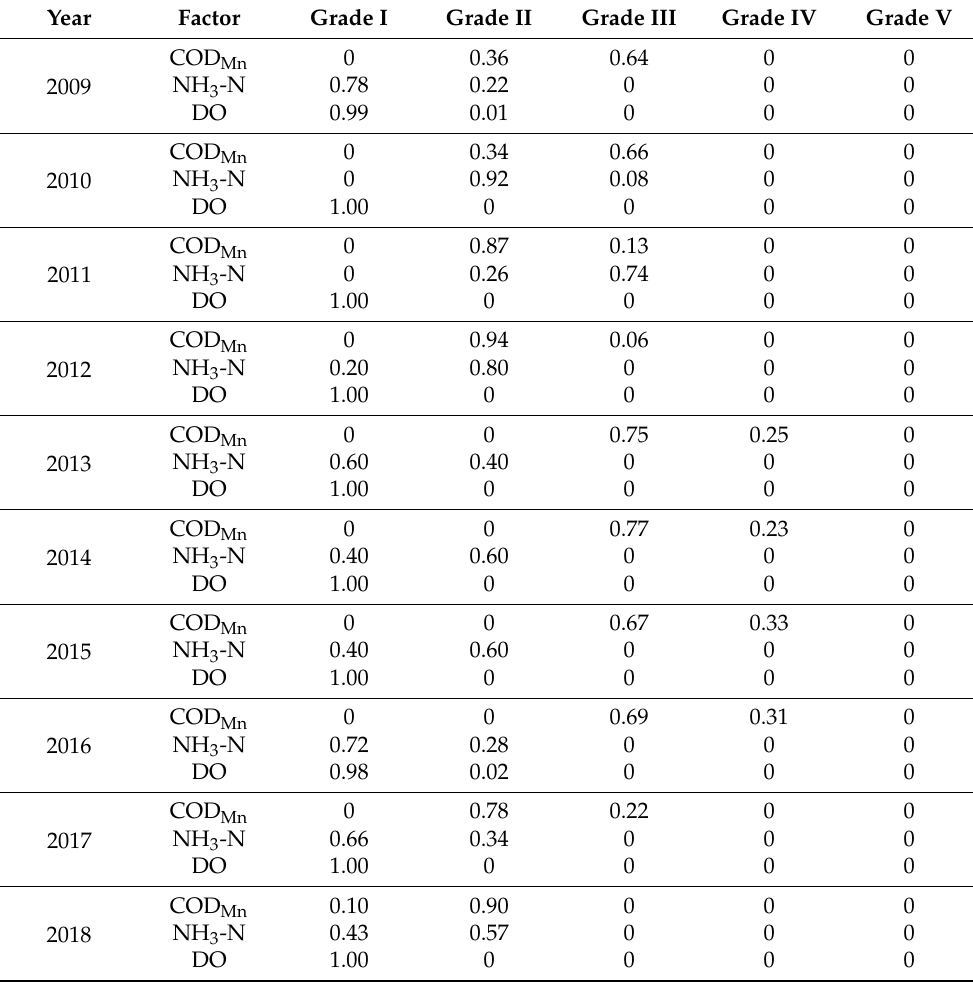
Table A5. Fuzzy matrix of Lanshanzui Station in Yixing,